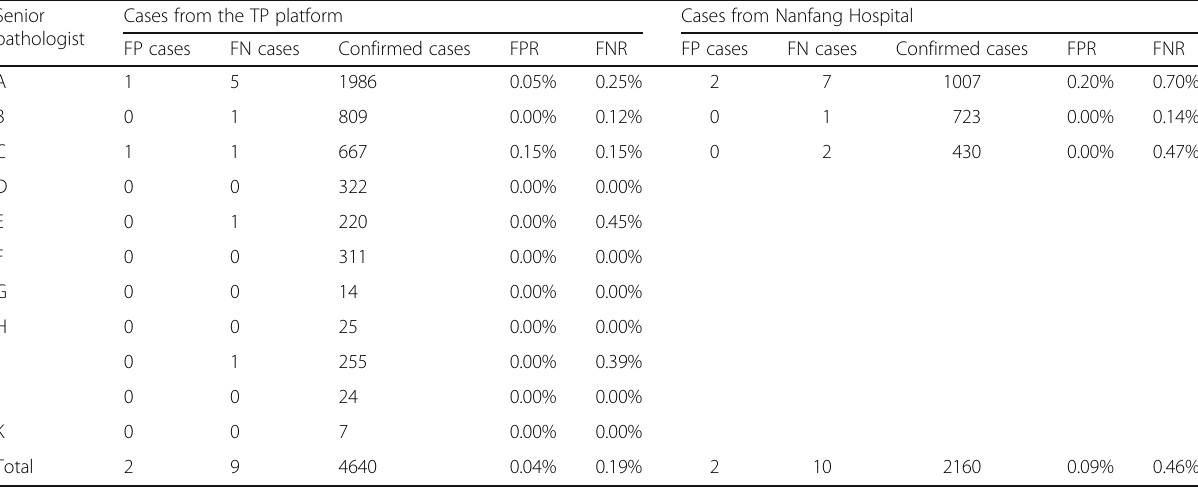
Table 5 The false negative rate (FNR) and false positive rate (FPR) of senior pathologists in the TP platform and Nanfang Hospital Senior Cases from the TP pathologist